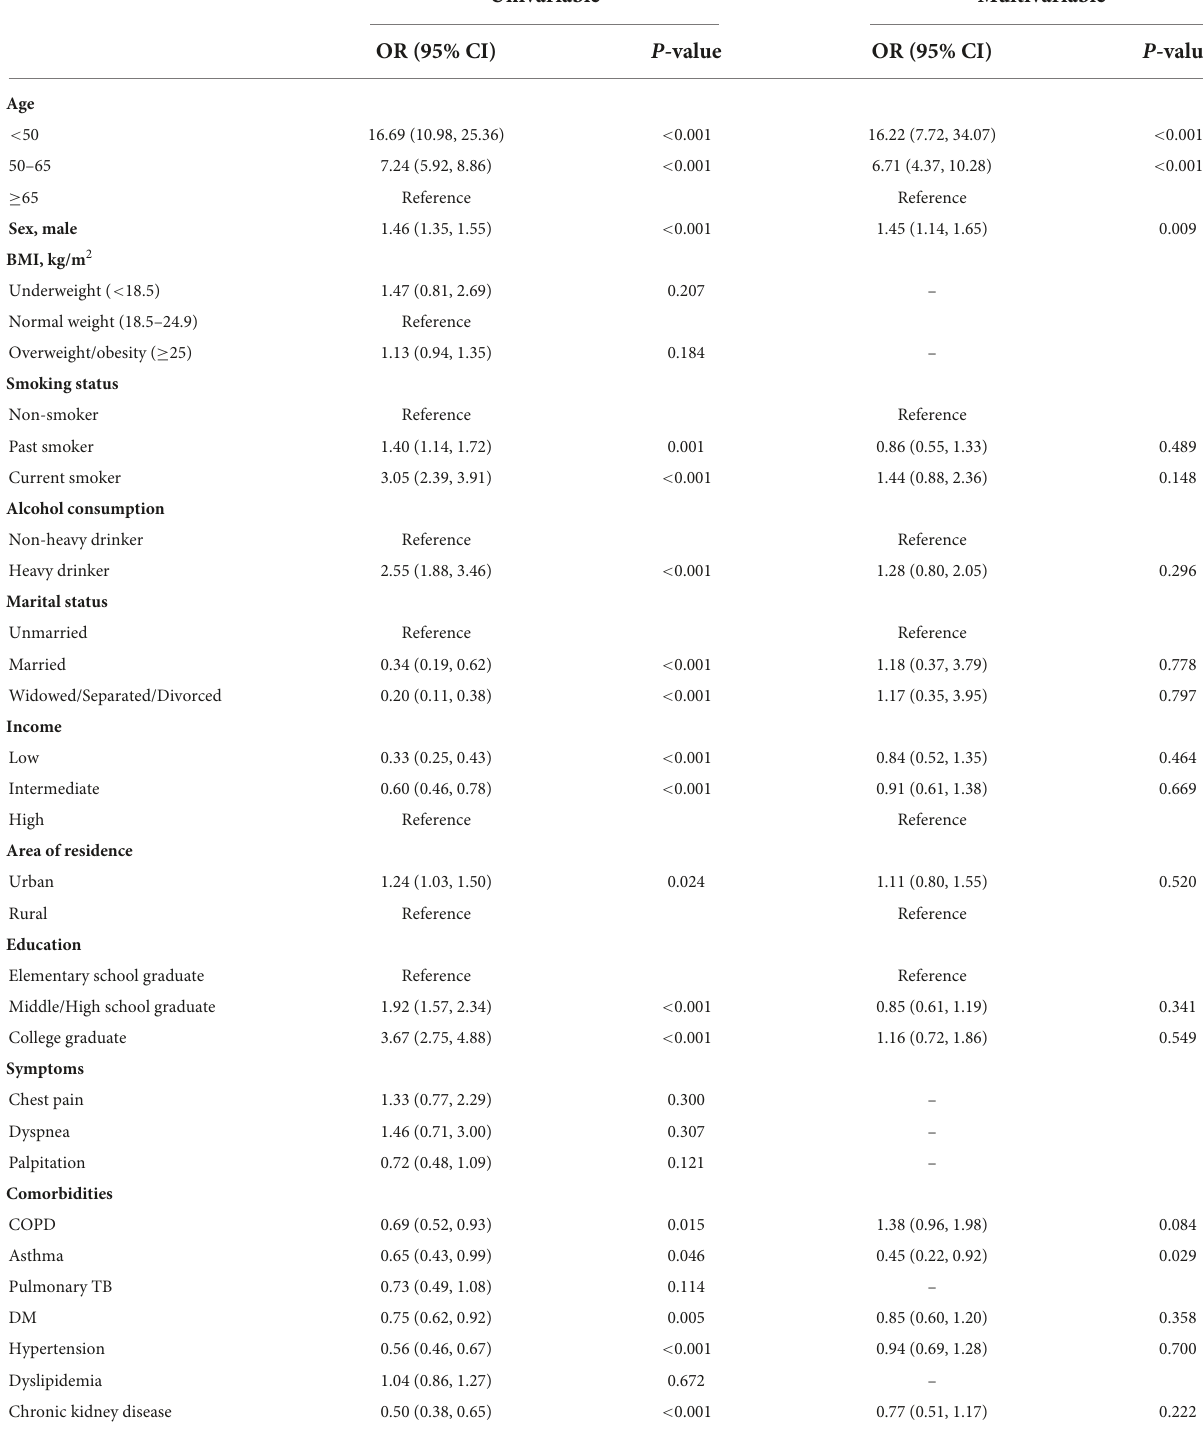
TABLE 2 Factors associated with influenza unvaccinated status in patients with cardiovascular disease. Univariable